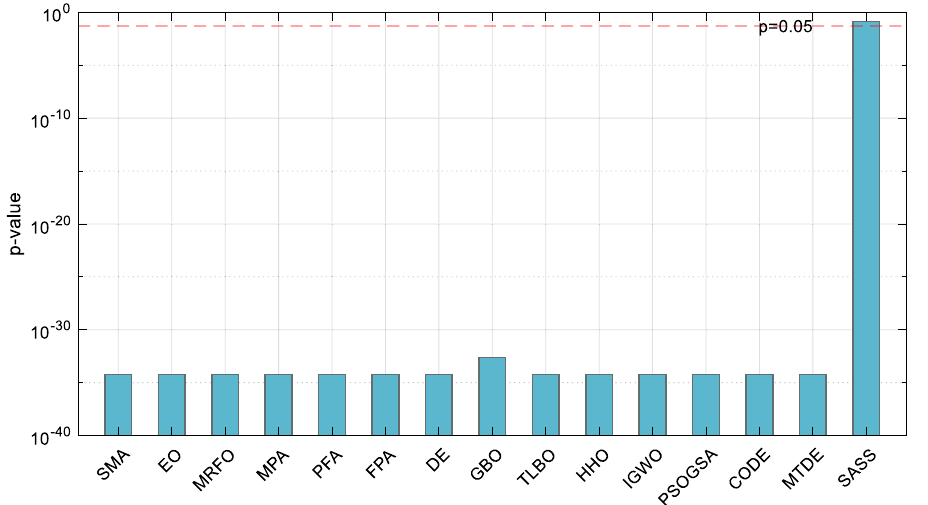
Figure 16. Wilcoxon rank-sum test results of randomly generated pose points.